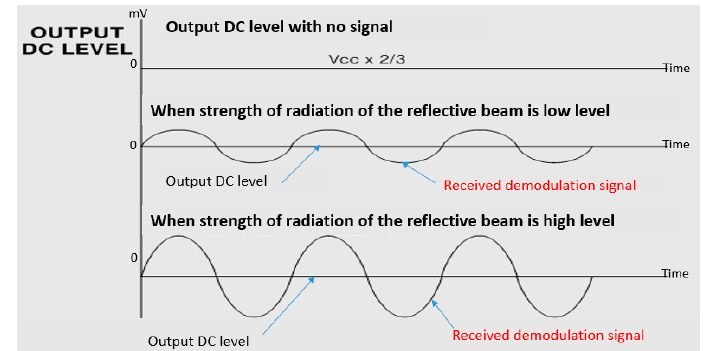
Figure 6. Principle of measurement for the strength of radiation of reflective beam.